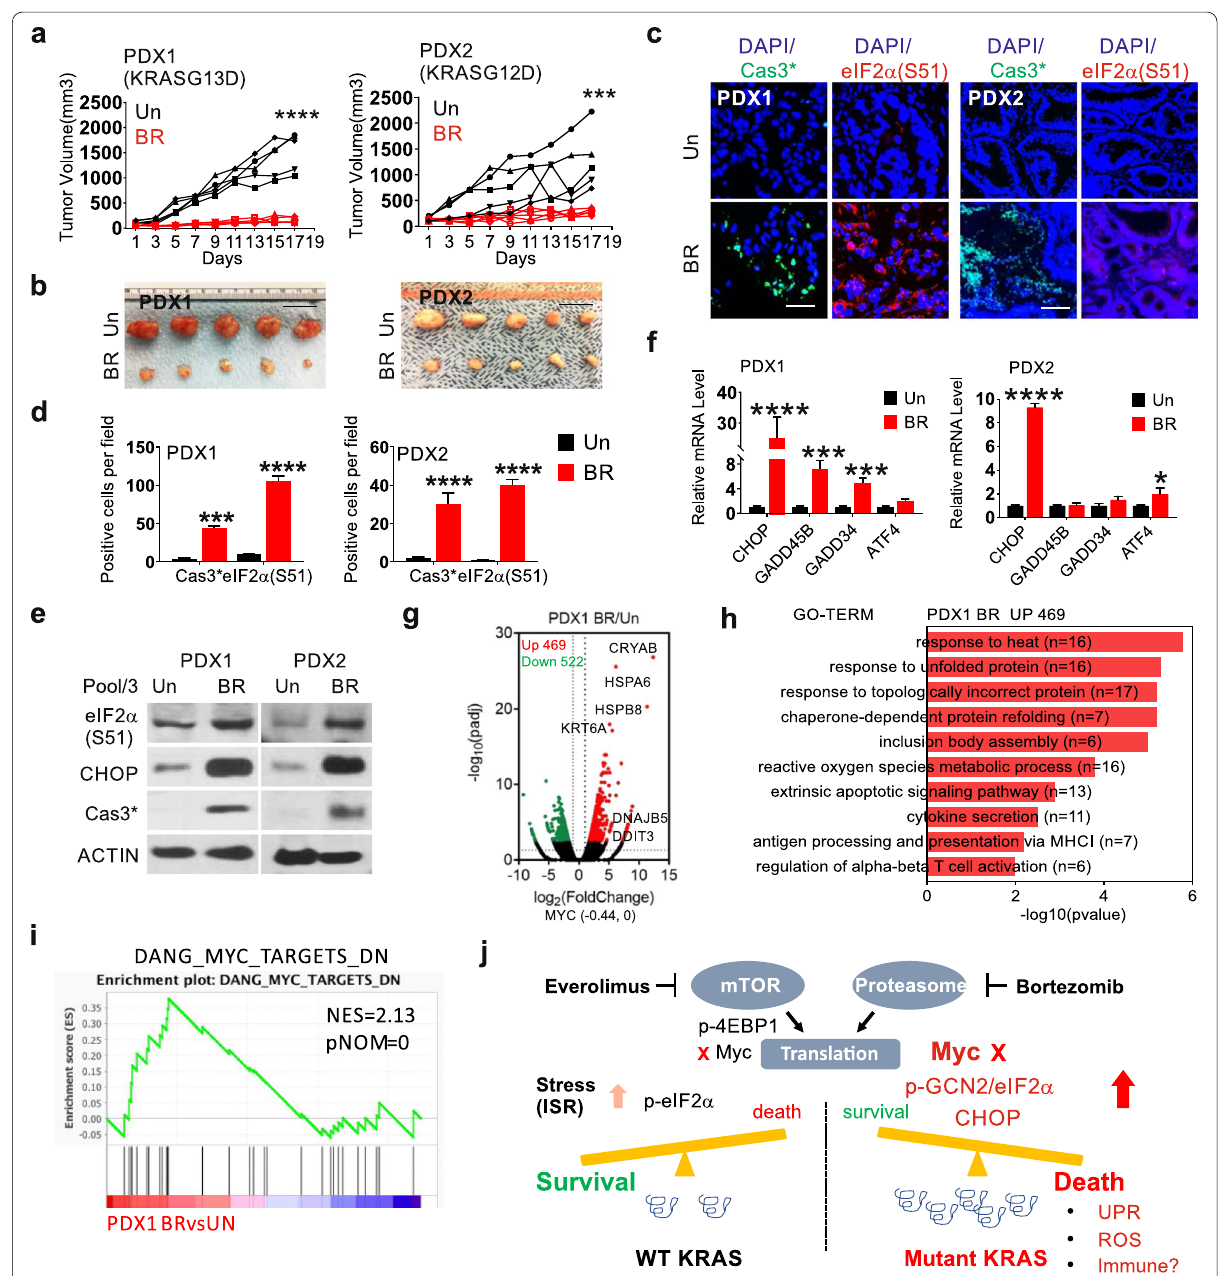
Fig. 6 The BR combination kills mutant KRAS MSS CRC PDXs. NSG were randomized into control and treatment groups when average PDX volume reached around 100 mm3. Mice were treated with vehicle (Un), or the combination of Everolimus (oral gavage, 10 mg/kg) and Bortezomib (i.p., 0.5 mg/kg) (BR) every other day starting day 1. Tumors were harvested for analysis. a Individual tumor volume was calculated and plotted ( n 5) = with b representative images on day 17. Scale Bar 2 cm. c Representative cleaved caspase 3 and p-eIF2α IF with DAPI counterstain (blue) on = day 4. Scale Bar 100 µM. d Quantification of cleaved-caspase 3 and p-eIF2α IF as ( c ) in 3 randomly chosen 400X fields. e Western blotting of = indicated proteins on day 4. N 3 (pooled). f qRT-PCR of indicated makers on day 4. The values were normalized to Un (1). N 3 (pooled mRNA). g = = BR DEGs in PDX1 on day 4 visualized by volcano plot. Upregulated (red) or down regulated (green) genes (fold 2, p < 0.005). Selected upregulated ≥ genes are shown. h Top 10 enriched non-overlapping pathways identified by GO in upregulated genes (469). i . GSEA of differential genes in PDX1 (C2 dataset). The indicated gene set is shown with NES and corresponding p -value. a, d, f, values are mean s.d. ( n 3 or as specified). * p < 0.05, + = ** p < 0.01, *** p < 0.001, **** p < 0.0001 (Student’s t -test, two tailed). Vehicle (Un) vs. BR. j Working model. Targeting Myc-driven stress in KRAS mutated CRCs. Compared to WT KRAS CRCs, mutant KRAS CRCs show elevated basal Myc and metabolic stress. Acute ablation of Myc protein by the BR combination impairs their adaptation, leading to sustained ISR (p-GCN2/p-eIF2α/CHOP) and cell death associated with UPR, reactive oxygen species (ROS) production, and immune